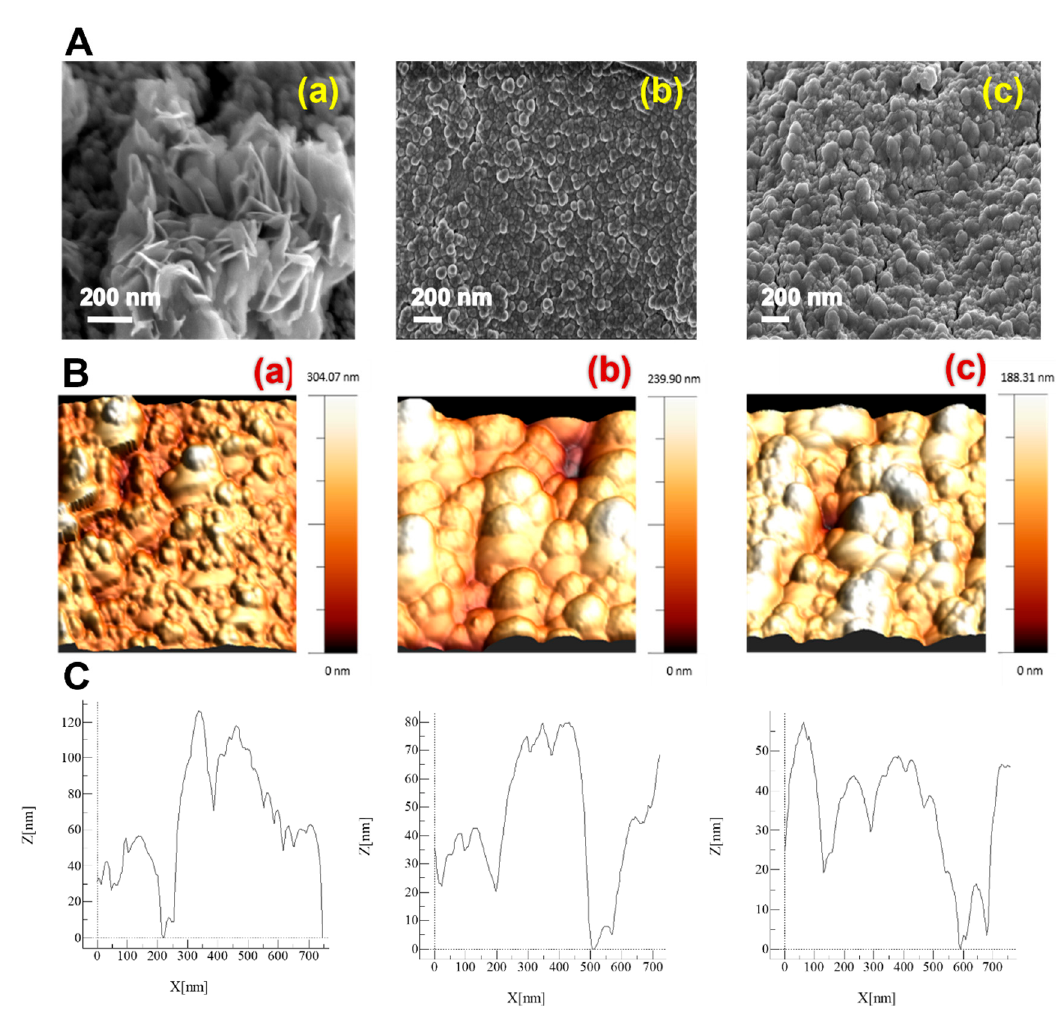
Figure 1. ( A ) SEM images, ( B ) AFM images and ( C ) rugosity profiles of various SPCE modified electrodes: ( a ) MoS2 nanosheets; ( b ) PPyNPs obtained by pulsed electropolymerization, and ( c ) MoS2 /PPyNPs nanocomposite.